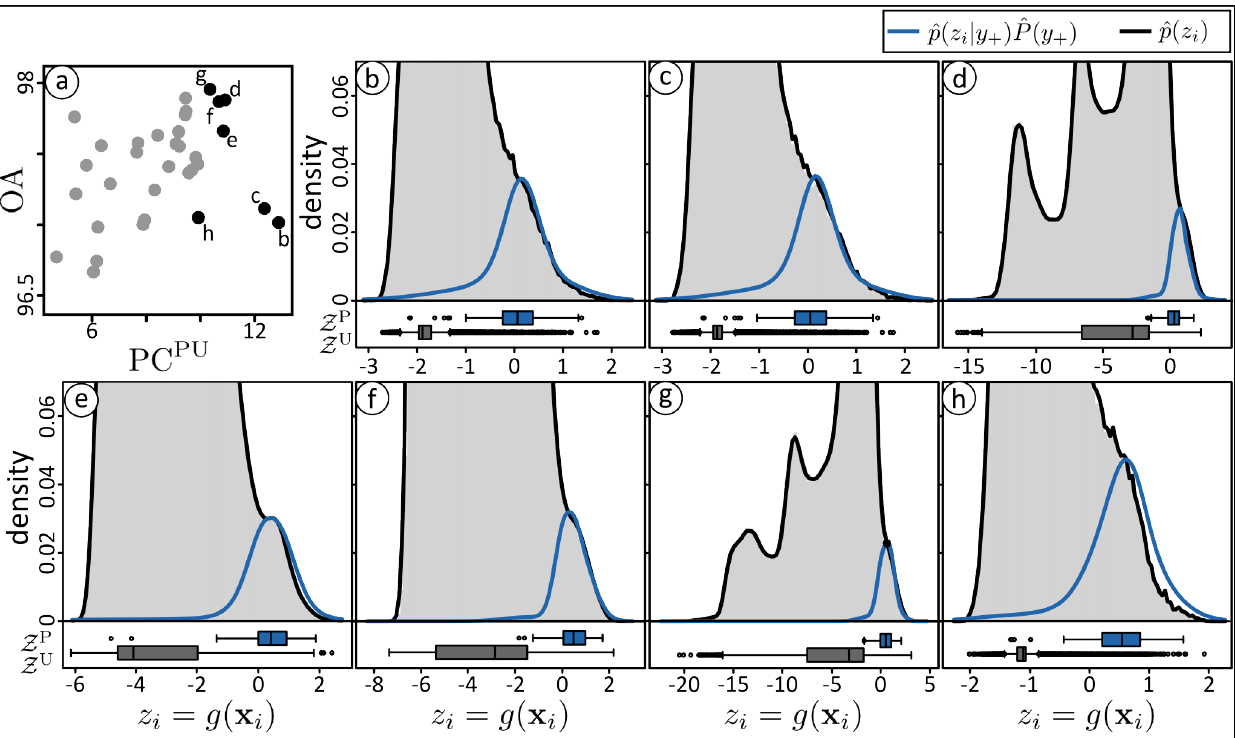
Figure 5. ( a ) Optimization criteria PC PU and maximum overall accuracy OA of